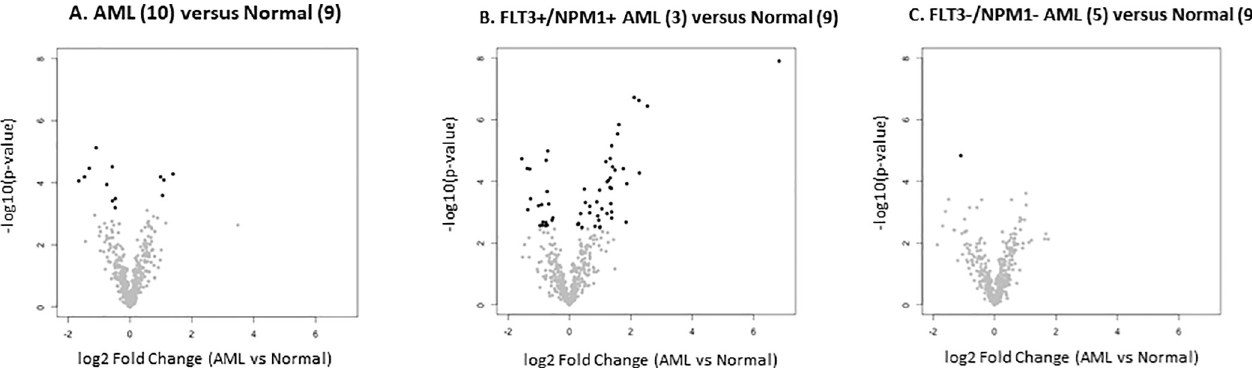
Fig 1. Volcano plots showing differences in miRNAs expressed in leukemia versus control peripheral blood. X-axis: log2 Fold Change Y-axis: -log10(p- value). A. AML versus Normal (n = 10) B. FLT3+/NPM1+ AML versus Normal (n = 3) C. FLT3-/NPM1- AML versus Normal (n = 5).